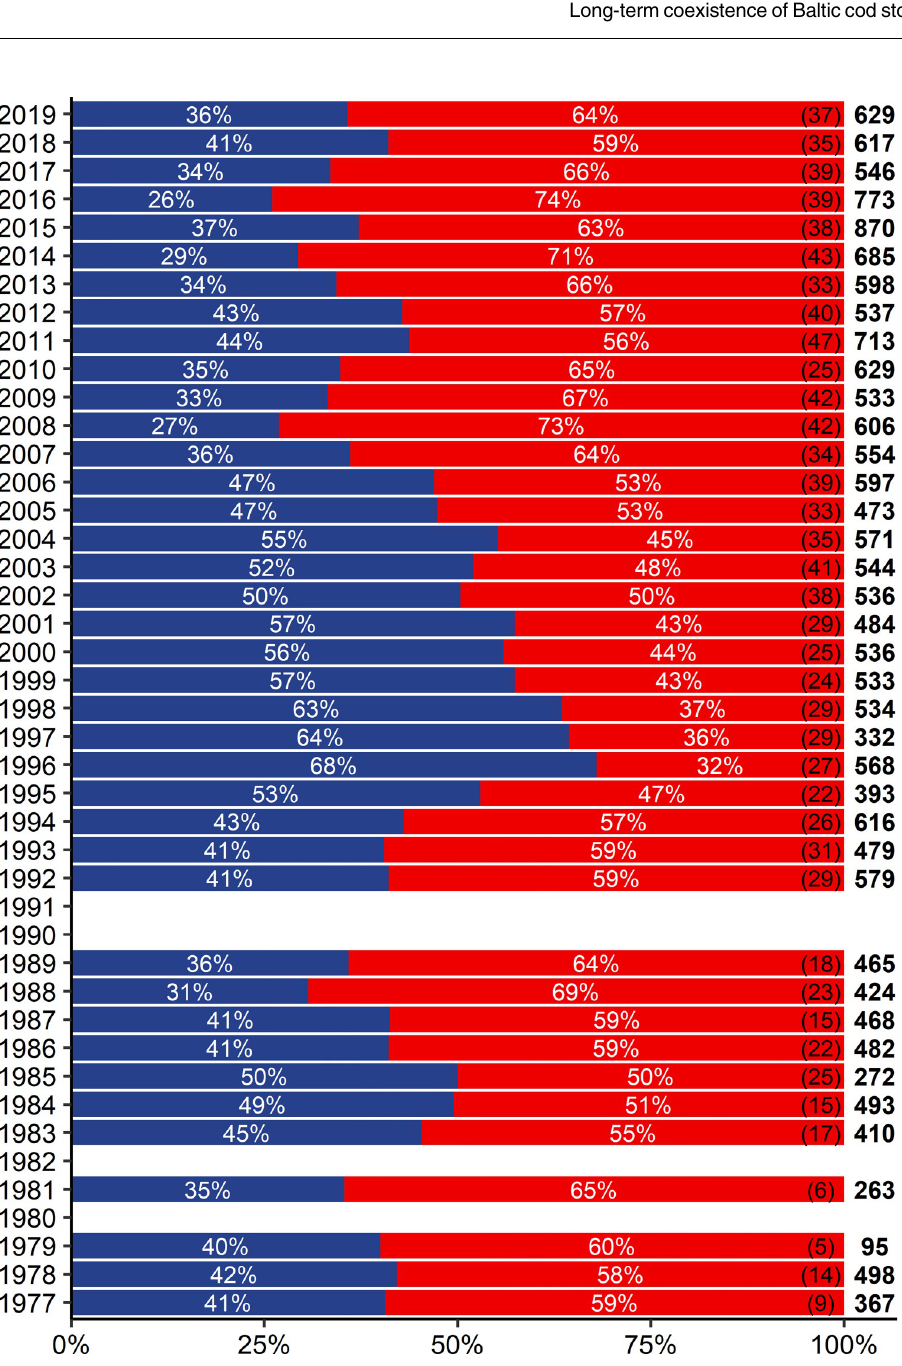
Fig 2. Annual mixing proportions of the Baltic cod stocks in SD 24. Mixing proportions of WBC (blue) and EBC (red) are based on cod samples (N = 20 302) from trawl surveys between 1977 and 2019. Total numbers of fishing hauls used in the stock mixing analysis (in brackets) and absolute numbers of otoliths used in the shape analysis (in bold) are given on the right side of each year. Years without bars = no data